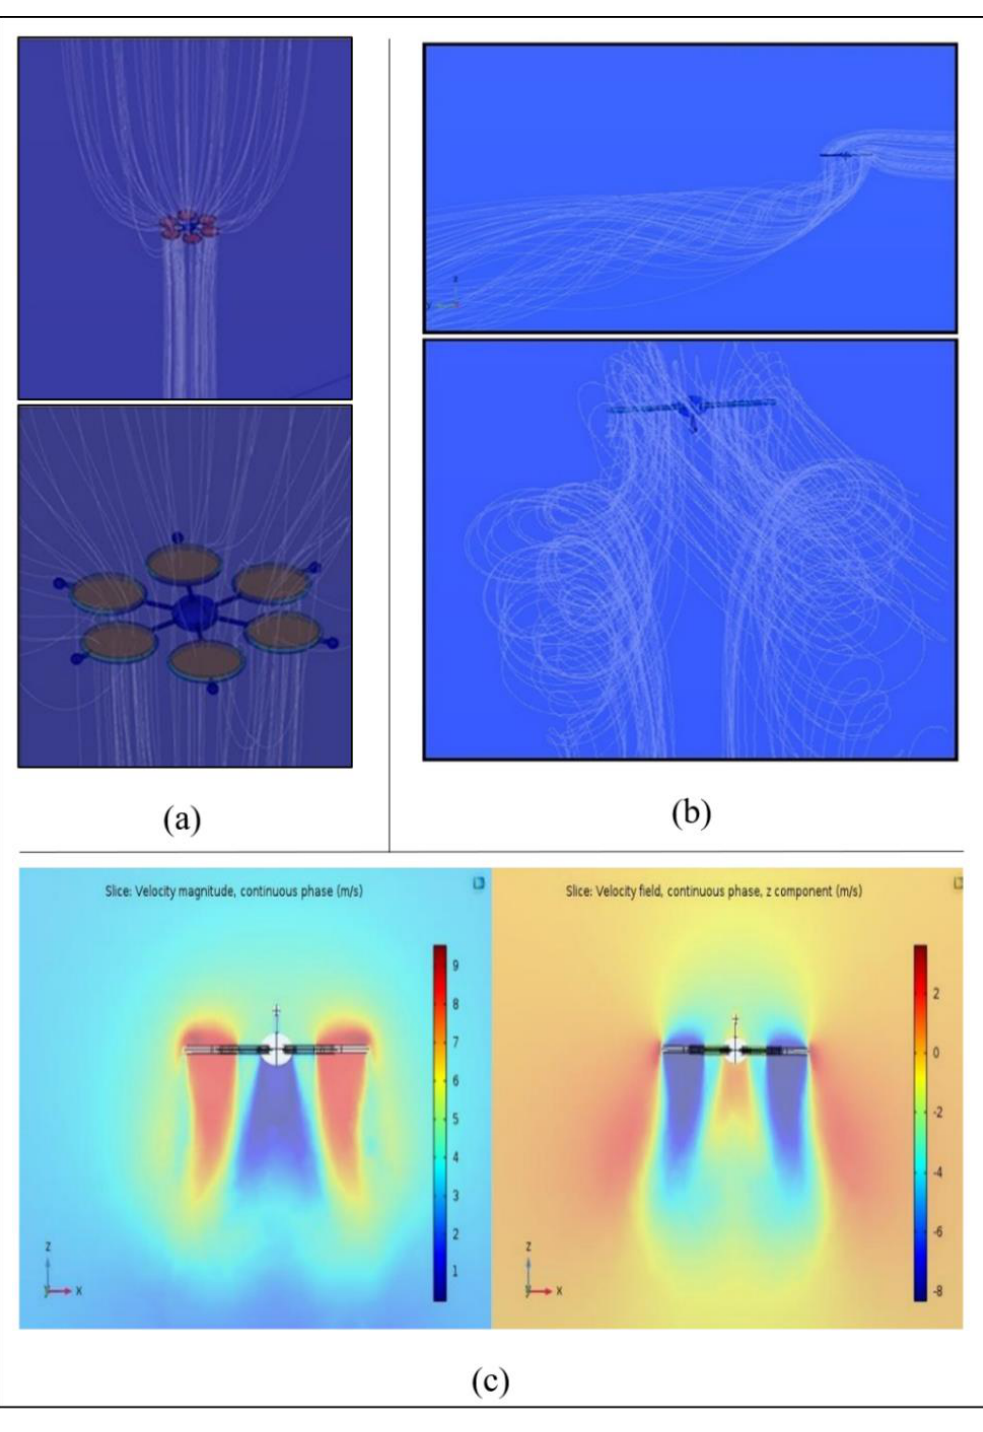
Figure 5. Air fluid flow lines expand before entering the drone domain, to account for the higher air amount requested by the engines and are concentrated downwards once re-entering into the reference domain ( a ); The same effect on the Nadir virtual drone prototype from two different points of view: as wind flow is absorbed by the upper side of the ducted propeller rotors is accelerated downwards. Re-interacting with the wind flow, the resulting vortexes are bent backward in a pattern very similar to that occurring at the aerodynamic flow leaving the wingtips of an aircraft during the flight ( b ); Velocity magnitude (left) and velocity along z-direction (right) near the drone ( c ). The flow lines of the continuous phase are shown in Figure 5a. By examining the flow lines, it is also evident that the air-fluid is behaving in the correct way since air exits the reference domain into